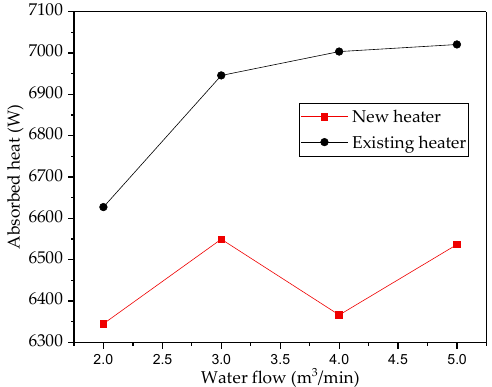
Figure 7. Absorbed heat of two heat exchangers.